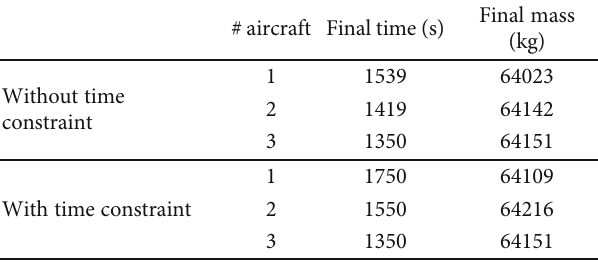
Table 2: Results of Experiment 1.